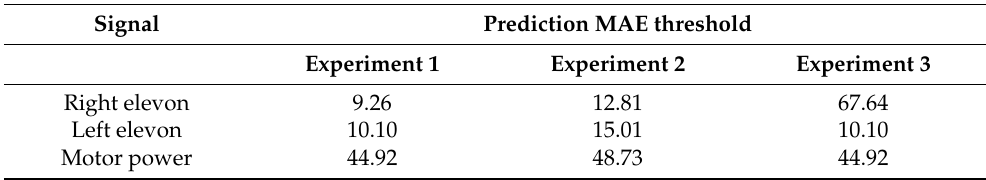
Table 5. Comparison of mean absolute error (MAE) threshold values used in each experiment, where the experiments have the same labels as Table 3.